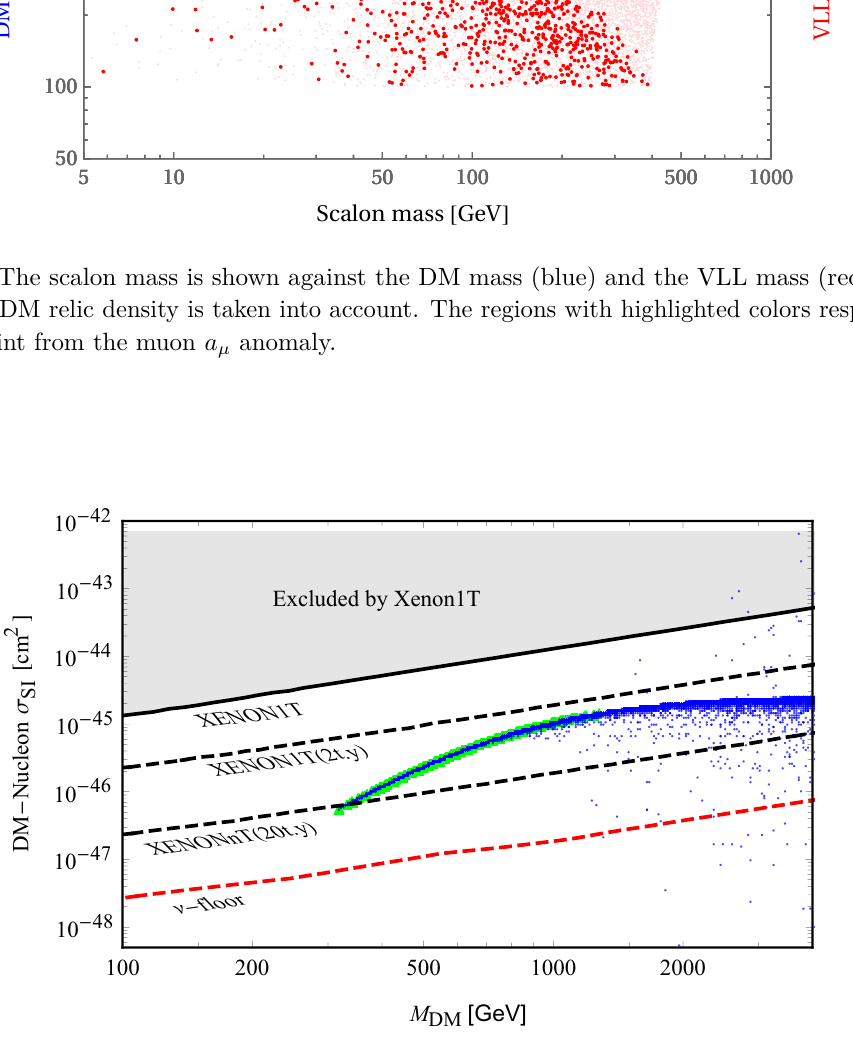
Figure 7 . The DM mass vs. spin-independent DM-nucleon cross section is shown. The blue region is the parameter space with the observed DM relic density. The green region in addition explains the muon anomalous magnetic moment. Almost all viable regions for the DM relic density and the muon anomaly lies below the current and future DD